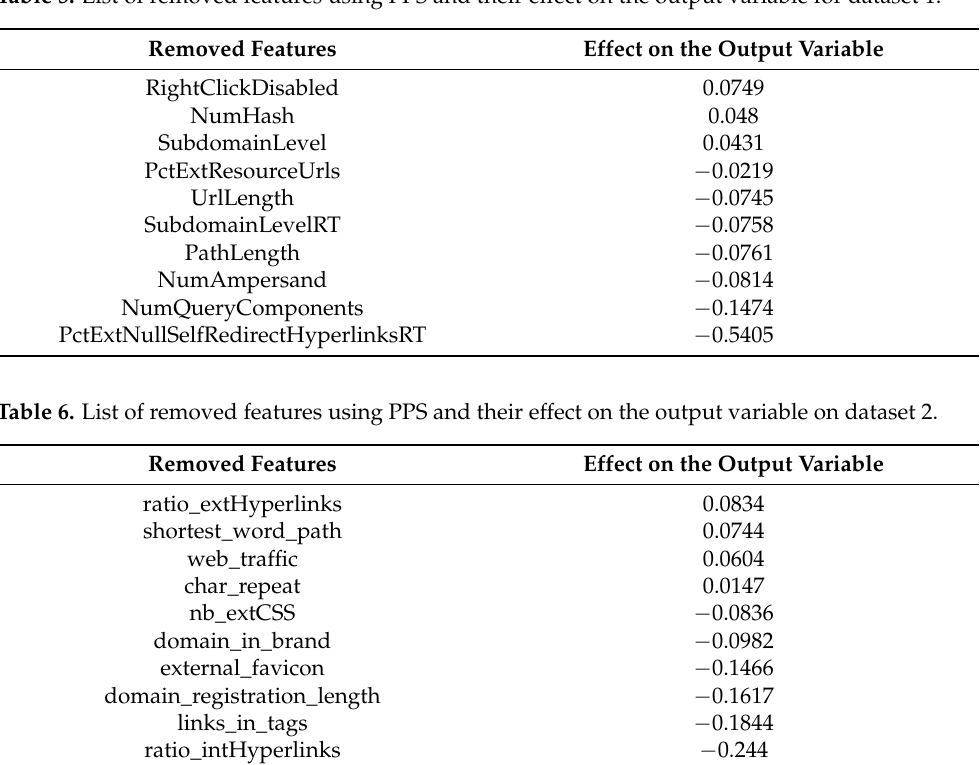
Table 5. List of removed features using PPS and their effect on the output variable for dataset 1.